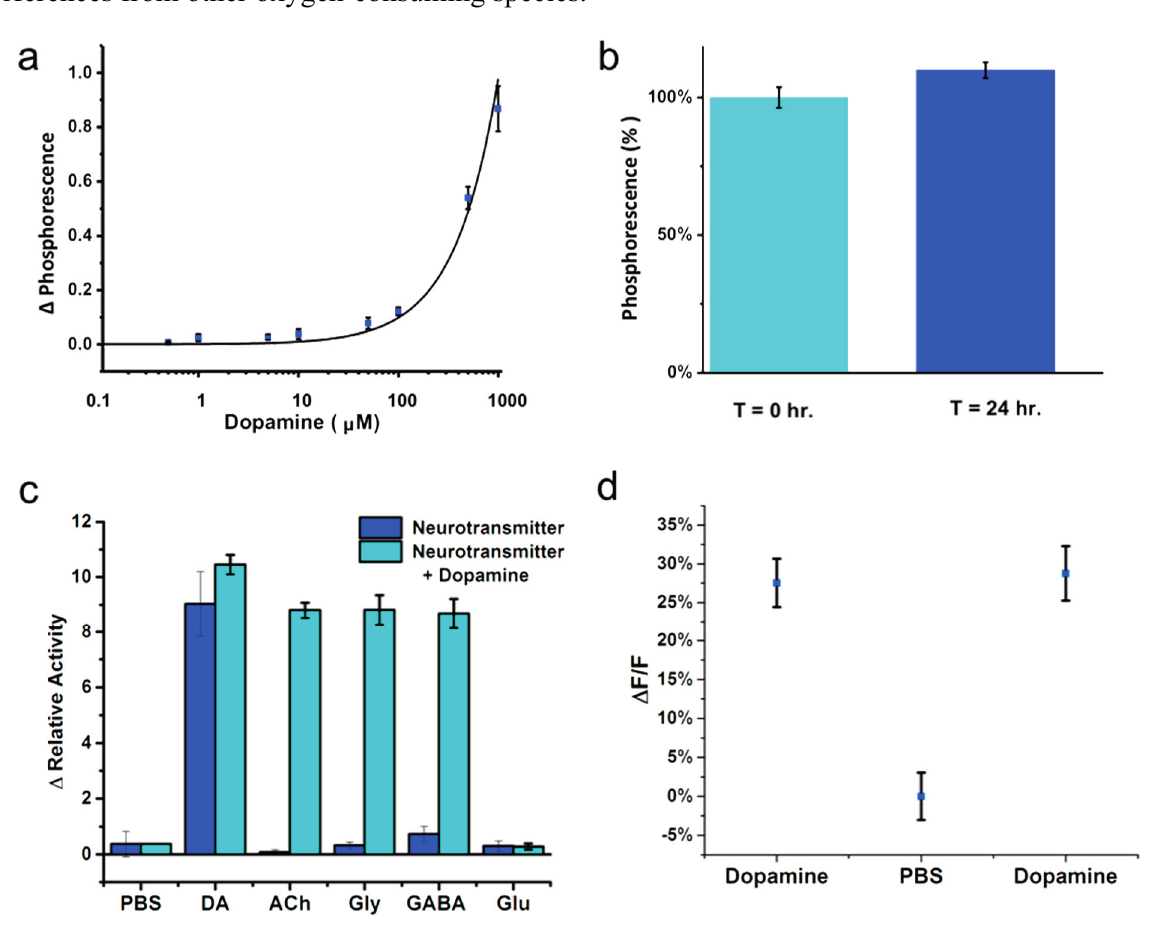
Figure 4. The nanosensors’ sensitivity and selectivity were measured using phosphorescence spectroscopy. ( a ) Response of dopamine sensing nanosensors from 0.01 μ M –1 ·mM